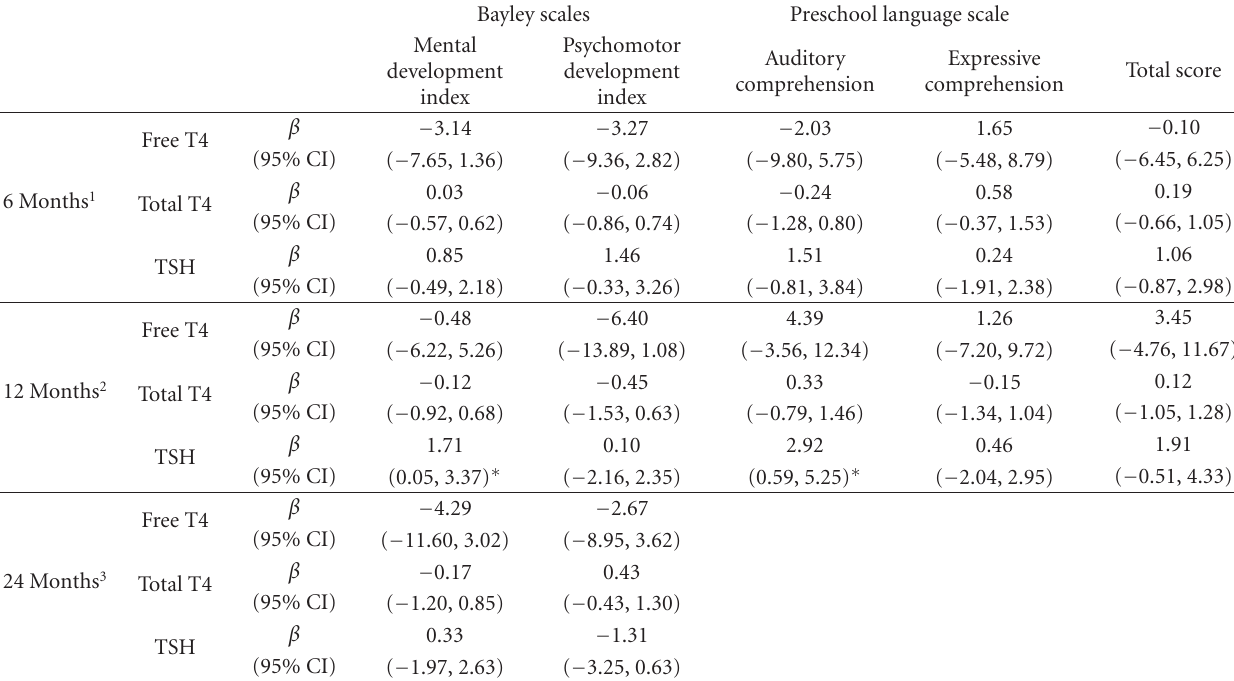
Table 4: Associations between maternal thyroid hormone levels during pregnancy (27 weeks’ gestation) and child neurodevelopment at 6, 12 and 24 months of